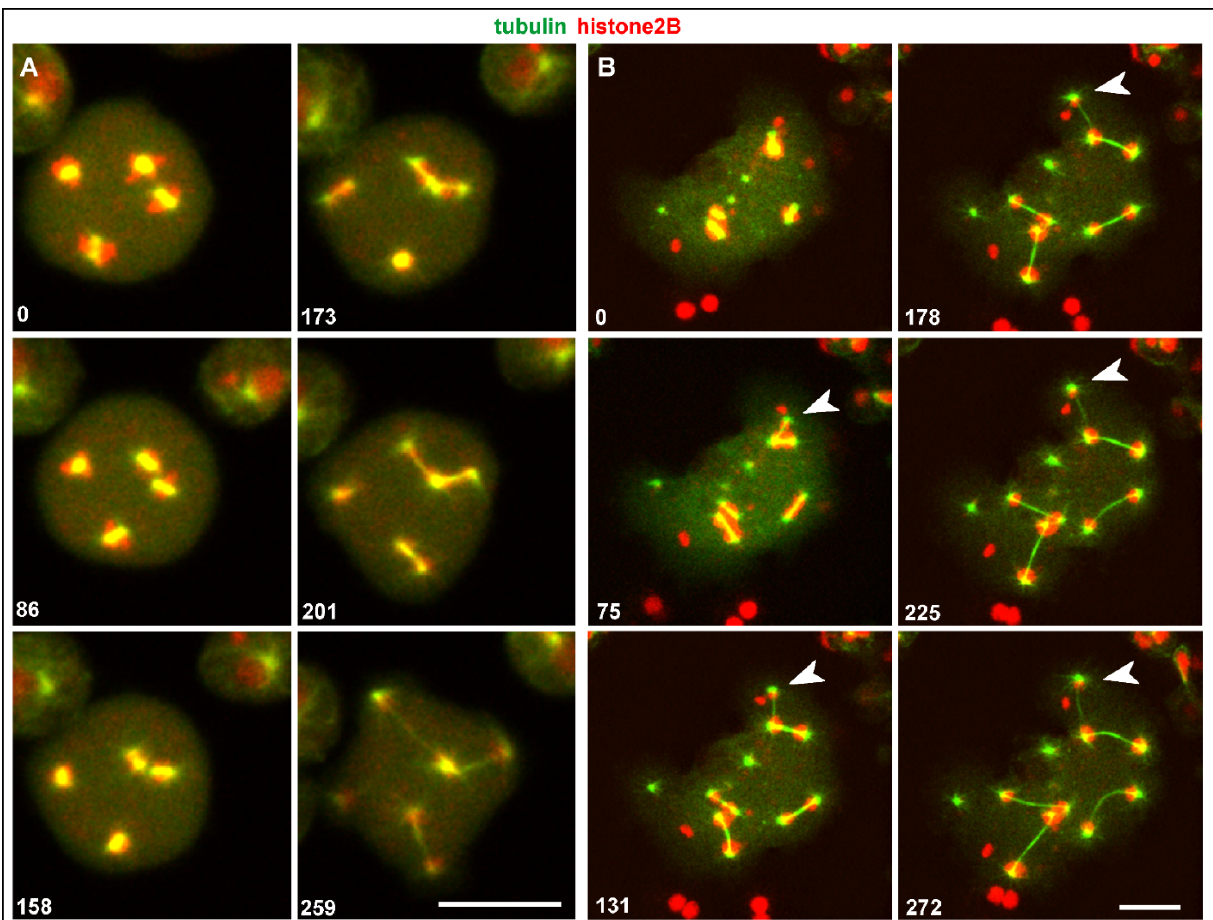
Figure 4. Centrosome fusion followed by unequal sets of chromosomes translocated by two spindles. Cells expressed GFP- α -tubulin to visualize the mitotic apparatus (green) and RFP-histone2B to label the chromosomes (red). ( A ), centrosome fusion in a tetra-nucleate cell of a RacE-null mutant. Up to the metaphase stage, four separate mitotic complexes persisted (0-s to 158-s frames). Subsequently, two complexes joined each other by the fusion of two adjacent centrosomes (173-s and 201-s frames). As a result, the two elongating spindles formed by these complexes had one centrosome in common (201-s to 259-s frames). ( B ), in a Septase-null cell, two spindles arose from three centrosomes associated with one large nucleus. Only a small amount of histone-labeled material became translocated to the upper centrosome (arrowhead), indicating that an incomplete set of chromosomes was translocated to this pole. The cell is also shown in Video S2. Time is indicated in seconds. Bars, 10 µm.